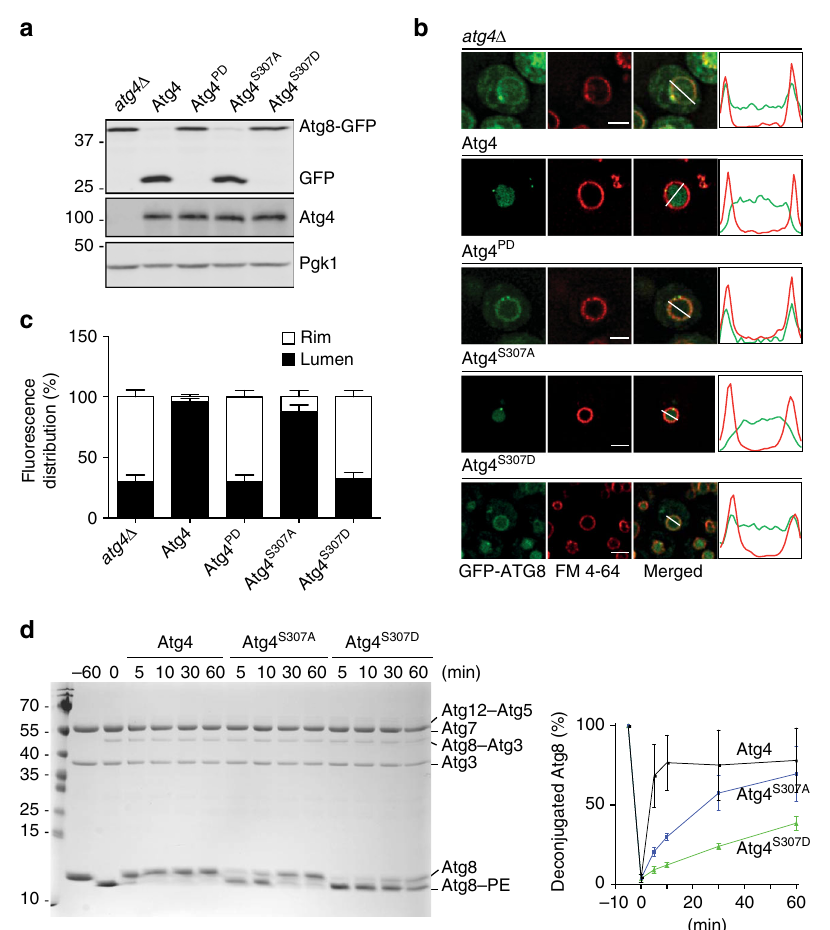
Fig. 2 Atg4 phosphorylation on serine 307 blocks Atg4 function. a The atg4 Δ cells carrying the integration plasmid pCuATG8GFP(403) (SAY114) and an empty vector ( atg4 Δ ) or plasmids expressing the indicated 13xmyc-tagged Atg4 variants were grown in SMD and nitrogen starved in SD-N medium for 3 h. Proteins were precipitated with TCA and analyzed by western blot. b The atg4 Δ strain carrying the integration plasmid pCuGFPAtg8 Δ R(305) (JSY151) or plasmids expressing the indicated 13xmyc-tagged Atg4 variants were grown in SMD, nitrogen starved in SD-N for 3 h, labeled with the vacuole-speci fi c dye FM 4-64 and imaged. Differential interference contrast (DIC). Scale bar , 5 µ m. Fluorescence intensity plots of representative vacuoles are shown (indicated by white lines ). c Quanti fi cation of GFP-Atg8 Δ R distribution on vacuole, i.e., rim vs. lumen, in cells imaged in a was performed as described in Methods. Results are mean ± SD ( n = 50). d Atg8 Δ R was conjugated to SUVs via the addition of Atg7, Atg3, Atg12 – Atg5, MgCl 2 , and ATP. Deconjugation was initiated by the addition of WT Atg4 or the indicated mutants. Samples were collected after 5, 10, 30, and 60 min, and separated on a 11% SDS gel supplemented with 4.5 M urea. The graph on the right shows the quanti fi cation of three independent